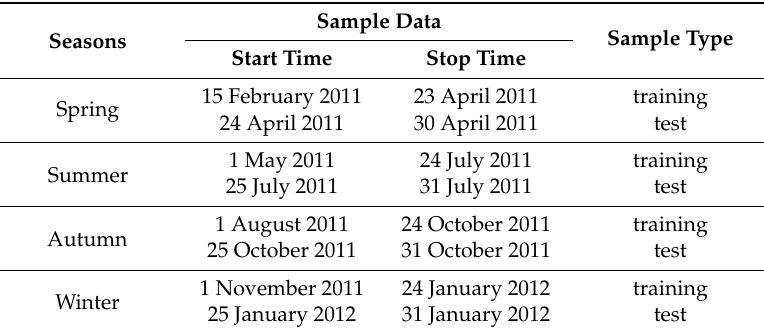
Table 3. Data sampling for the prediction models of Type 1 parameters.